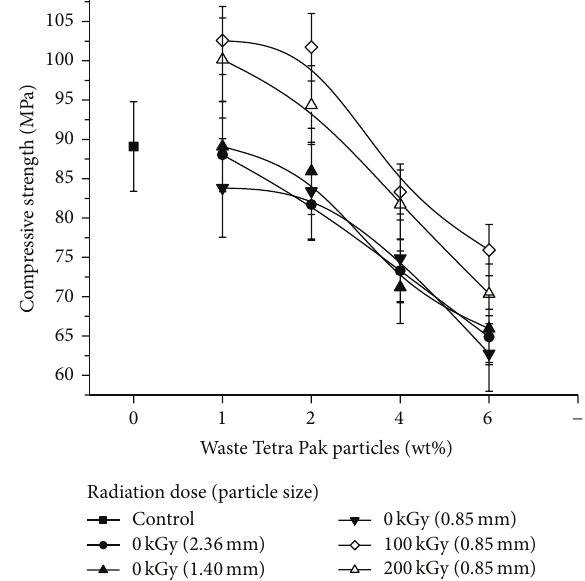
Figure 1: Compressive strength of polymer concrete in terms of waste particle size and irradiation